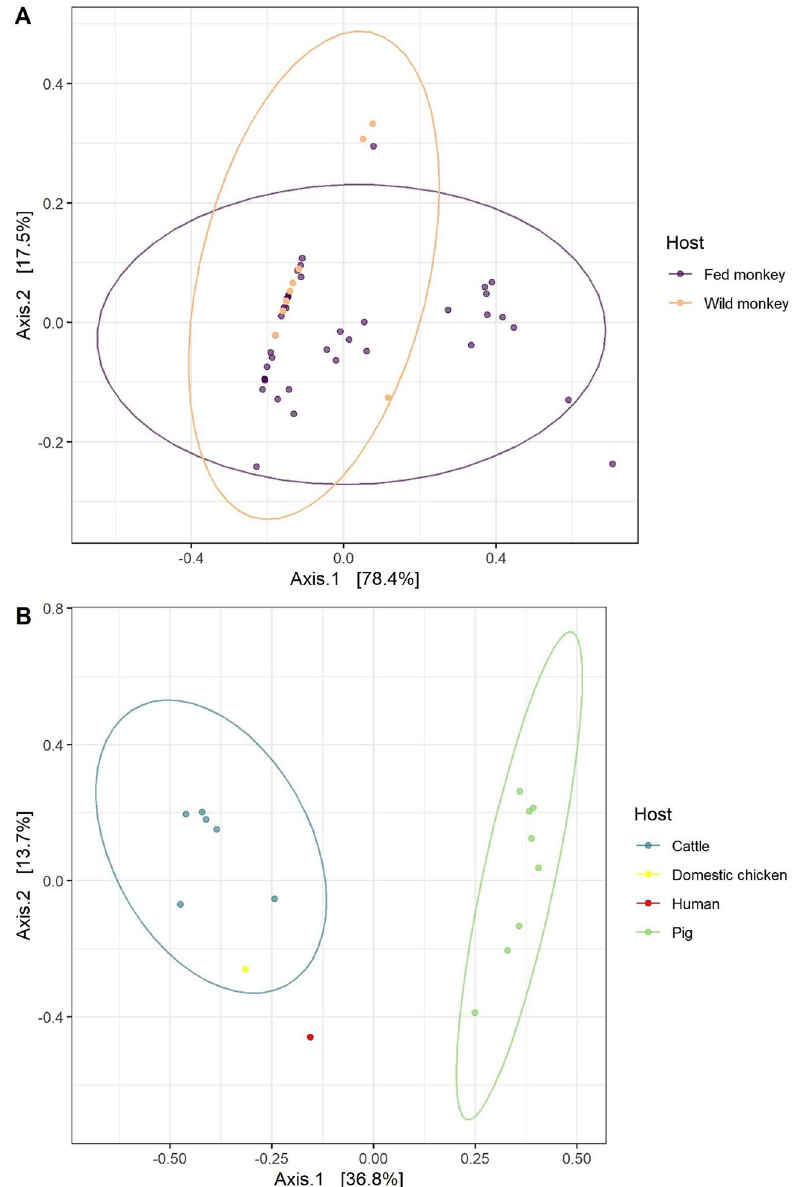
Figure 10. Principal Coordinate Analysis ordination for Bray–Curtis dissimilarities of Entamoeba OTU